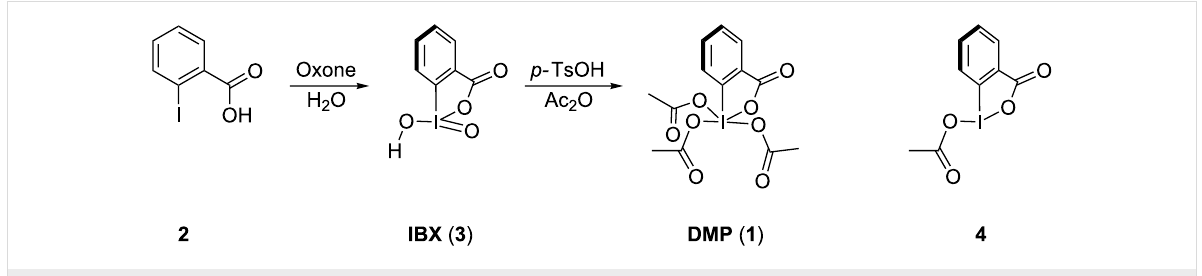
Figure 1: The chemical structures of DMP ( 1 ), 2-iodobenzoic acid ( 2 ), IBX ( 3 ) and 4